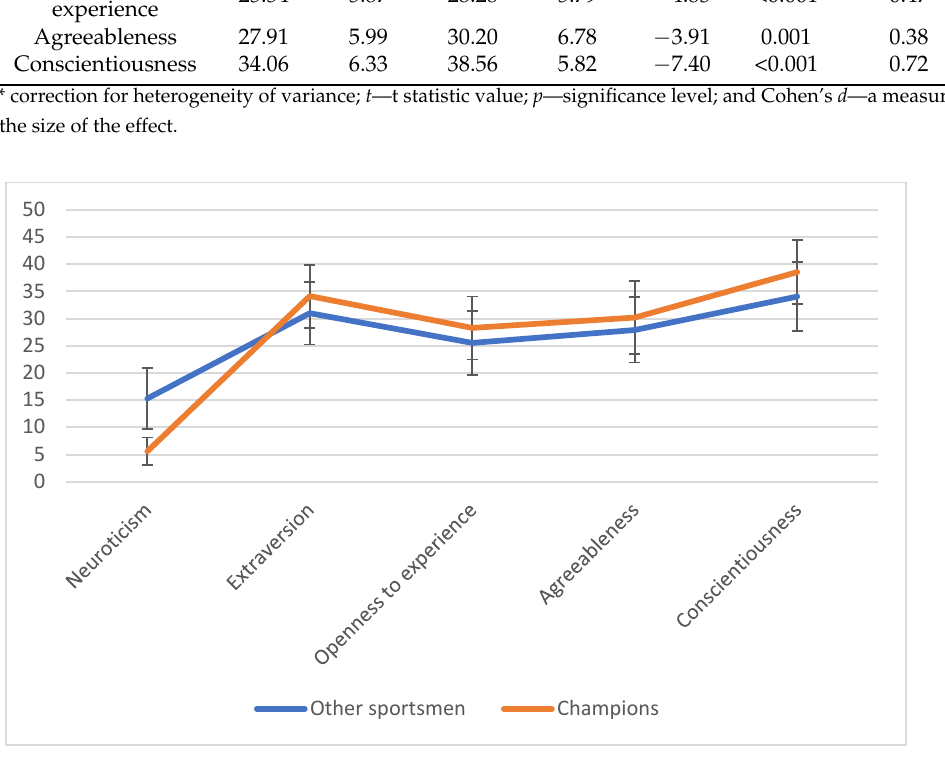
Figure 1. Line graph of personality profiles; breakdown into champions and other athletes.